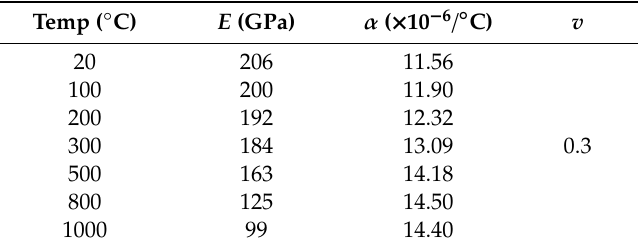
Table 3. Mechanical properties of AISI 1045 steel.